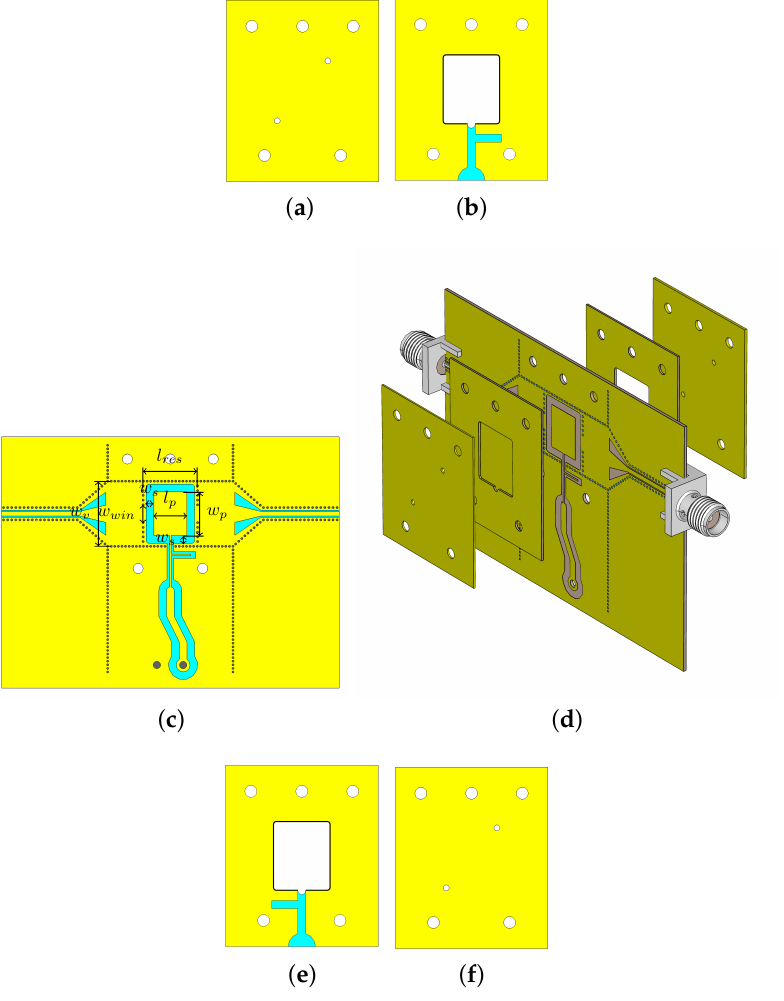
Figure 3. Layouts of the resonator layers : ( a ) top view of layer 1, ( b ) top view of layer 2, ( c ) top view of layer 3, ( d ) explosion view of the device, ( e ) bottom view of layer 4, and ( f ) top view of layer 5. Yellow is copper, blue is clearance, grey is plated through hole vias, white is empty zone, and black lines are plated